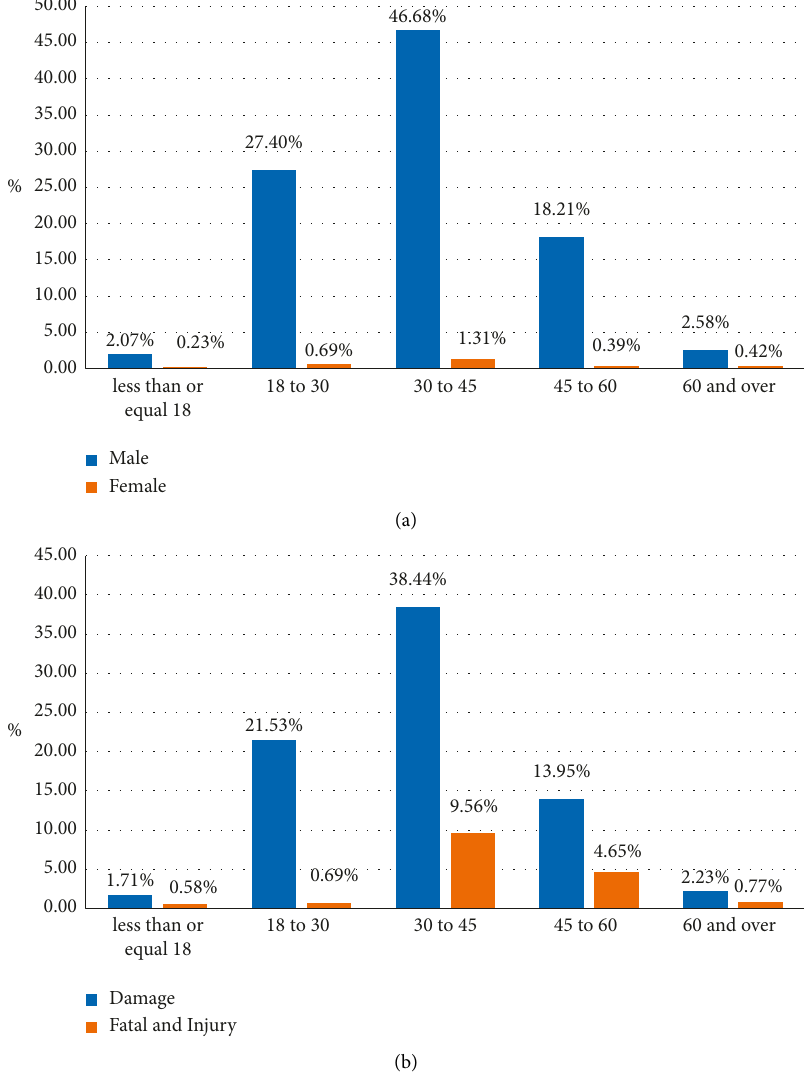
Figure 6: Statistics of vehicle accidents based on age: (a) gender of the driver and (b) severity of